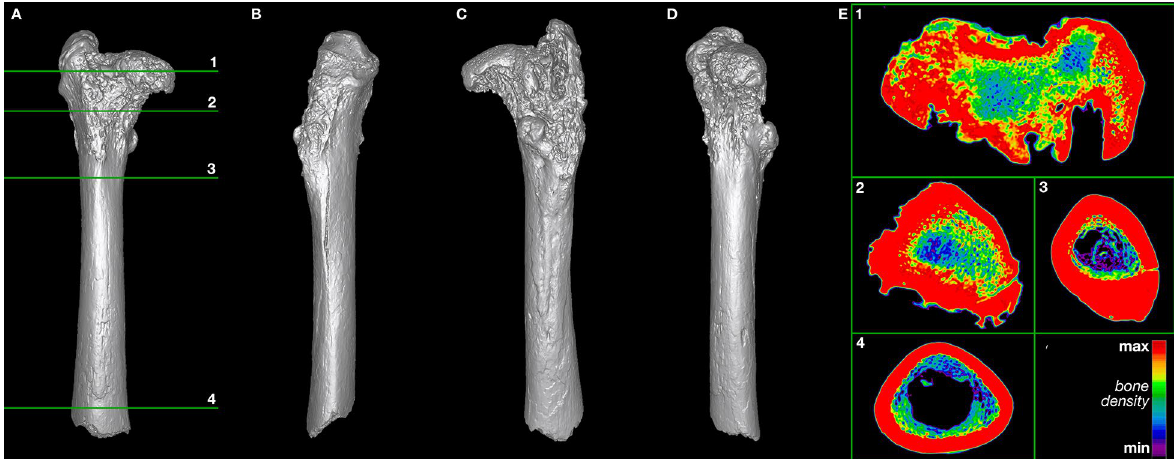
Figure 4. Three-dimensional model of the pathological Smilodon right femur (LACMHC 6963). Horizontal numbered lines in ( A ) mark anatomical location of numbered CT slices displayed in ( E ). ( A ) Anterior view of right femur; ( B ) rotated 90 degrees from anterior about the vertical axis (lateral view); ( C ) rotated 180 degrees from anterior about the vertical axis (posterior view); ( D ) rotated 270 degrees from anterior about the vertical axis, displaying the femoral head and neck (medial view). ( E ) 0.63 mm axial CT images of the pathological right femur demonstrating morphological distortion at the femoral head and neck, corresponding with the three- dimensional model. Each inset image has been rotated so that top corresponds to anterior, right corresponds to anatomical right, bottom corresponds to posterior, and left corresponds to anatomical left sides. Model created using Mimics version 20.0 (https:// www. mater ialise. com/ en/ medic al/ mimics- innov ation- suite/